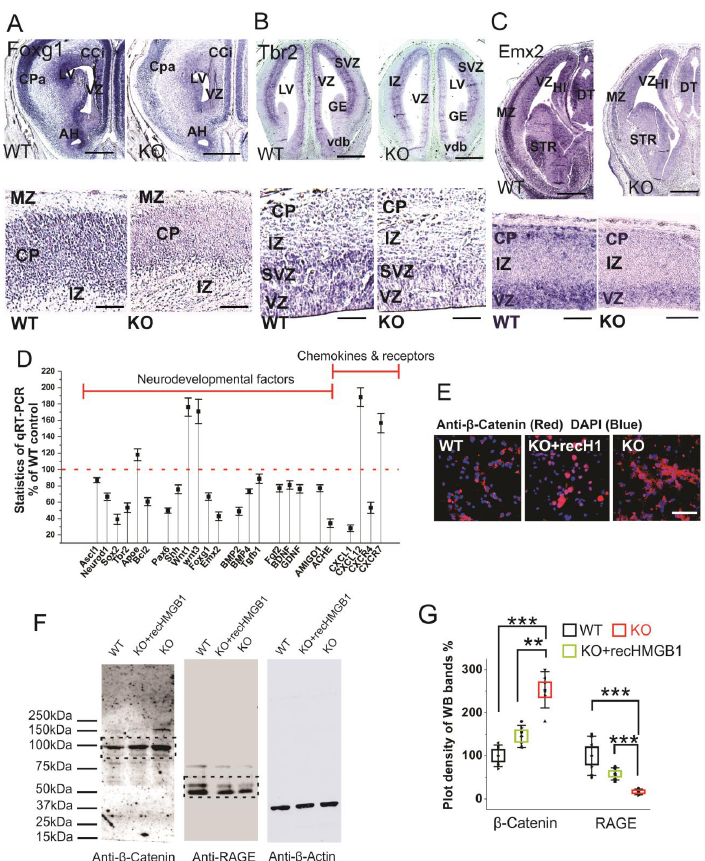
Figure 7. Expressions of neurodevelopmental factors in mouse dorsal telencephalon. ( A ) In situ hybridization of Foxg1 with E16 coronal sections. The higher resolution view in the lower panel clearly showed decreased Foxg1 expression in the CP of HMGB1 KO. The HMGB1 KO mouse also showed shrunken VZ and LV when compared to the WT. Scale bars indicate 1 mm in upper panel, and 200 μm, in the lower panel. ( B ) In situ hybridization of Tbr2 with E14 coronal sections and E16 saggital section (lower panel with higher resolution). The HMGB1 KO showed much less Tbr2 positive cells in the ventricular zone than WT. Scale bars indicate 1 mm in the upper panel and 100 μm in the lower panel. ( C ) In situ hybridization of Emx2 in the E16 coronal sections and E16 sagittal sections (lower panel with higher resolution). The coronal sections show decreased Emx2 expression in the prenatal cortex of the HMGB1 KO mouse when compared to the WT. Scale bar indicates 1.5 mm. The sagittal sections observed under higher resolution showed less Emx2 positive cells in the ventricular zone (VZ) and cortical plate (CP) in the HMGB1 KO as compared to the WT. Scale bar indicates 200 µ m, Abbreviations:AH, Anterior horn; CCi, Cingulate cortex; CPa, Parietal cortex; DT, Dorsal thalamus; GE, Ganglionic eminence; HI, Hippocampus; IZ, Intermediate zone; LV, Lateral ventricle; MZ, Marginal zone; Vdb, Vertical nucleus of diagonal band of Broca; STR, Striatum; VZ, Ventricular zone. ( D ) Expression of brain developmental factors detected by qRT-PCR. qRT-PCR has been repeated five times with the samples from five WT and five KO mice. Each sample has been independently tested at least three times. Mean values ± S.E.M (error bars) are indicated ( n = 5). ( E ) Anti- β -Catenin immunostaining of E16 cortical neurons cultured for two days. Cell nuclei were stained with DAPI (blue). Scale bar indicates 50 µ m. ( F ) Anti- β -Catenin and Anti-RAGE Western blotting of E16 neuronal cell samples cultured for 2 days. On lanes with multiple bands the relevant areas are encircled by rectangles. ( G ) Plot-density analysis of Western blotting bands of cultured cell samples. The experiment was repeated with the cell samples collected from six KO and six WT brains. Mean values ± S.D. (error bars) and S.E.M are indicated ( n = 6; *** p < 0.001; ** p < 0.01; unpaired t -test,